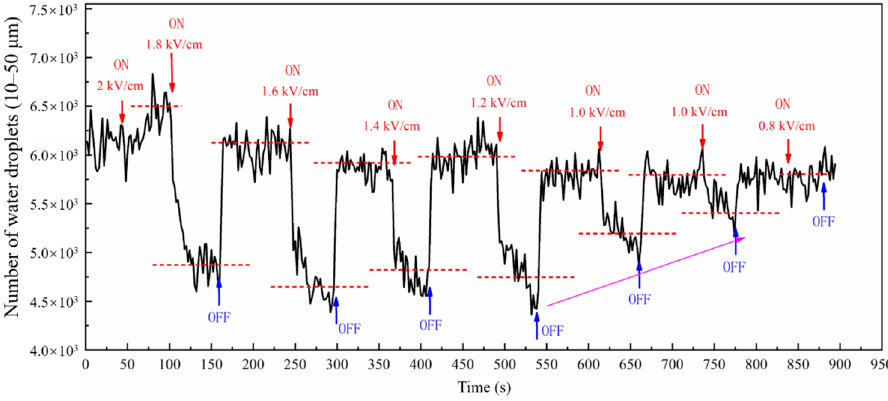
Figure 8. Variations of water droplet number within 10 to 50 μ m.